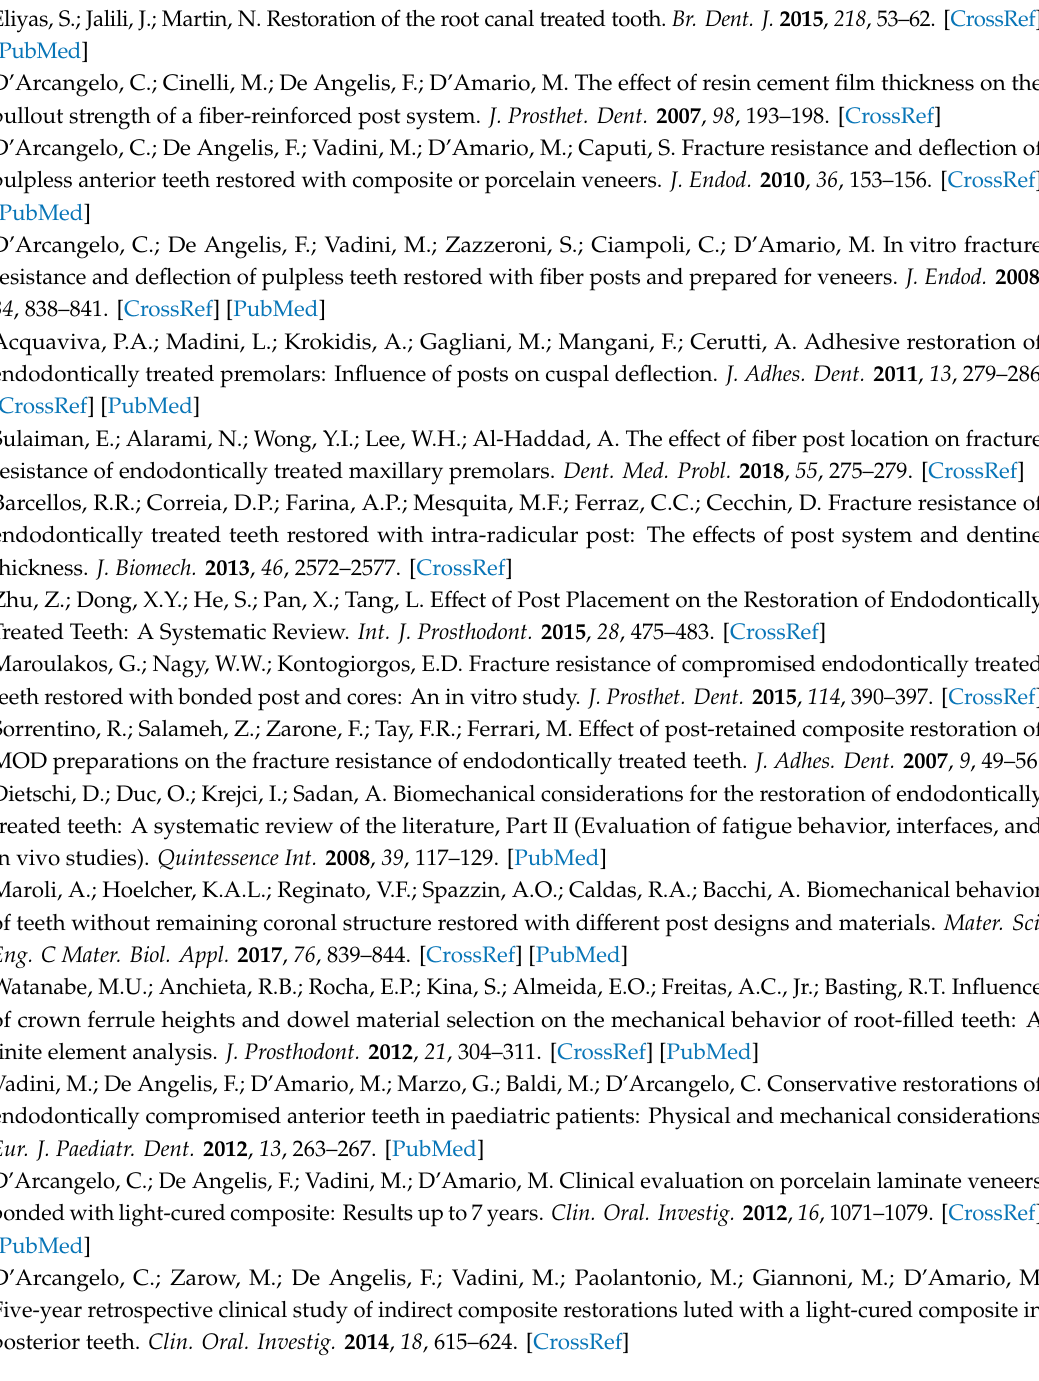
horizontal plane maps, placed at the level of the alveolar ridge, and calculated taking into account just dental tissues, Table S5: Quantitative analysis data of the stress distributions on root-furcation horizontal plane maps, calculated taking into account just dental